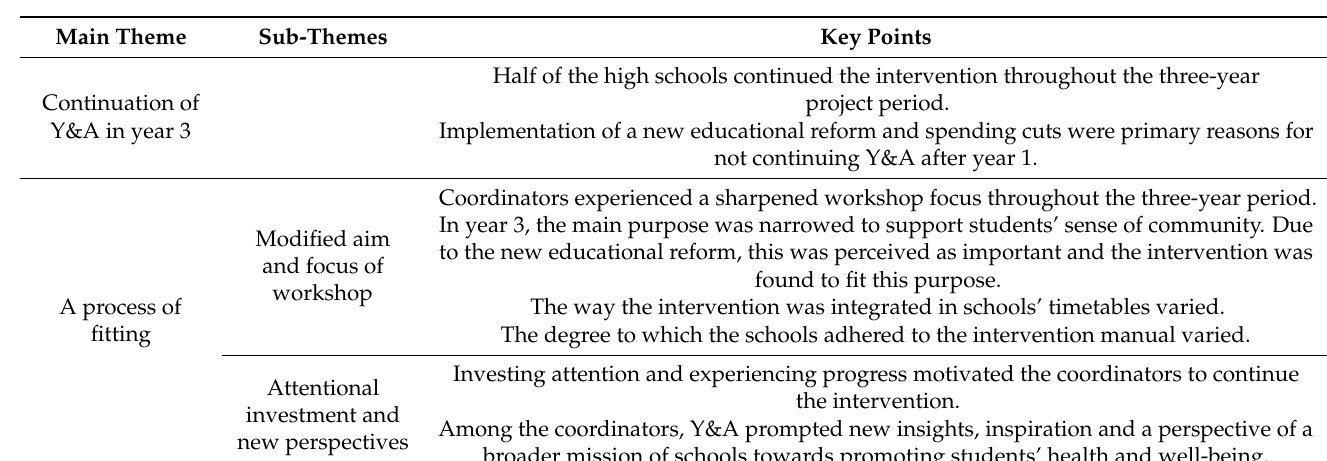
Table 2. Overview of themes and subthemes of